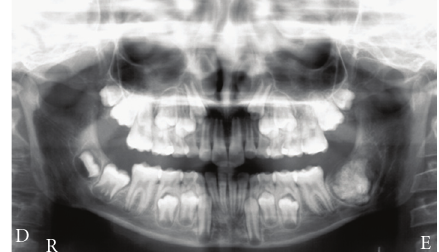
Figure 1: Initial panoramic radiography showing well-defined radiolucent region, which contained an irregular radiopaque mass measuring 3cm in diameter. This lesion occupied a zone from the lower left second molar area to the left ramus.